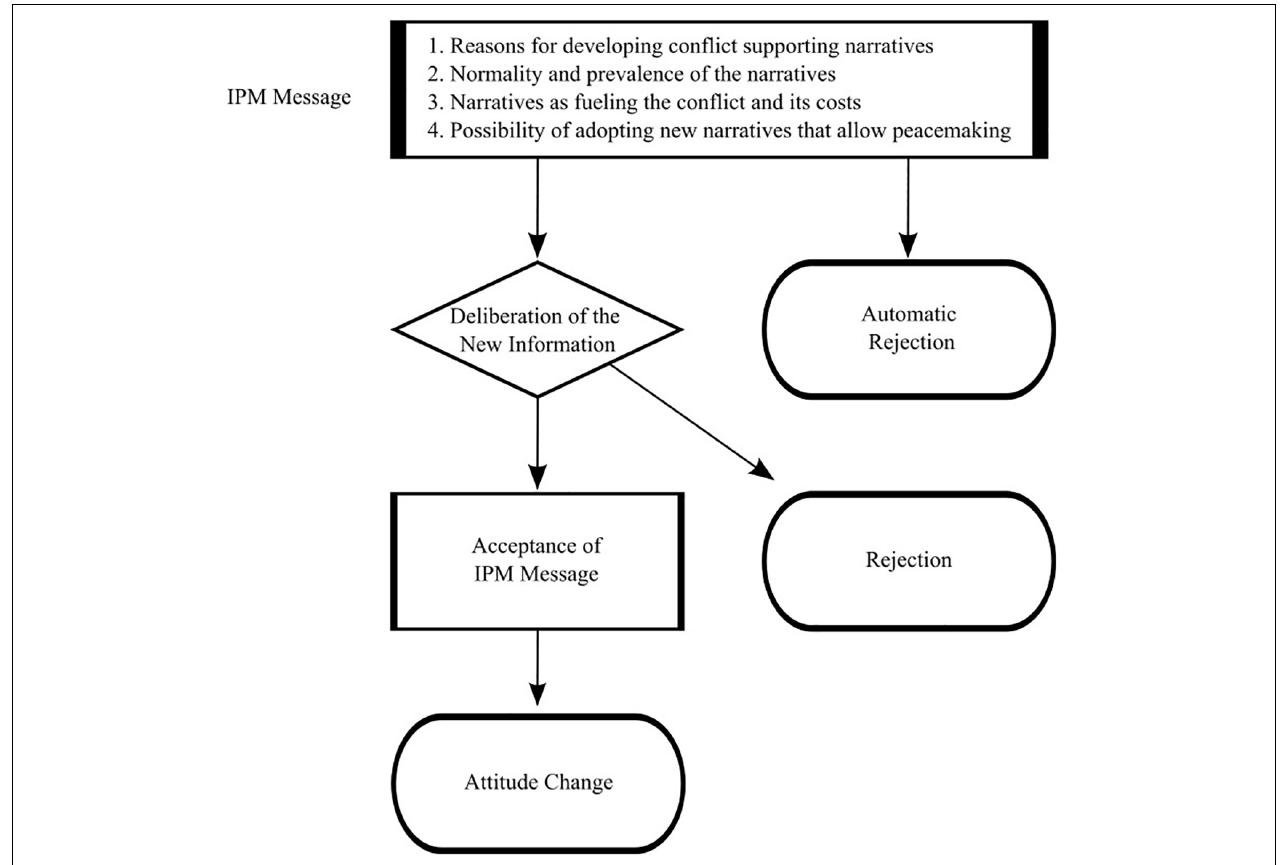
FIGURE 1 | The Informative Process Model (IPM) and its hypothesized